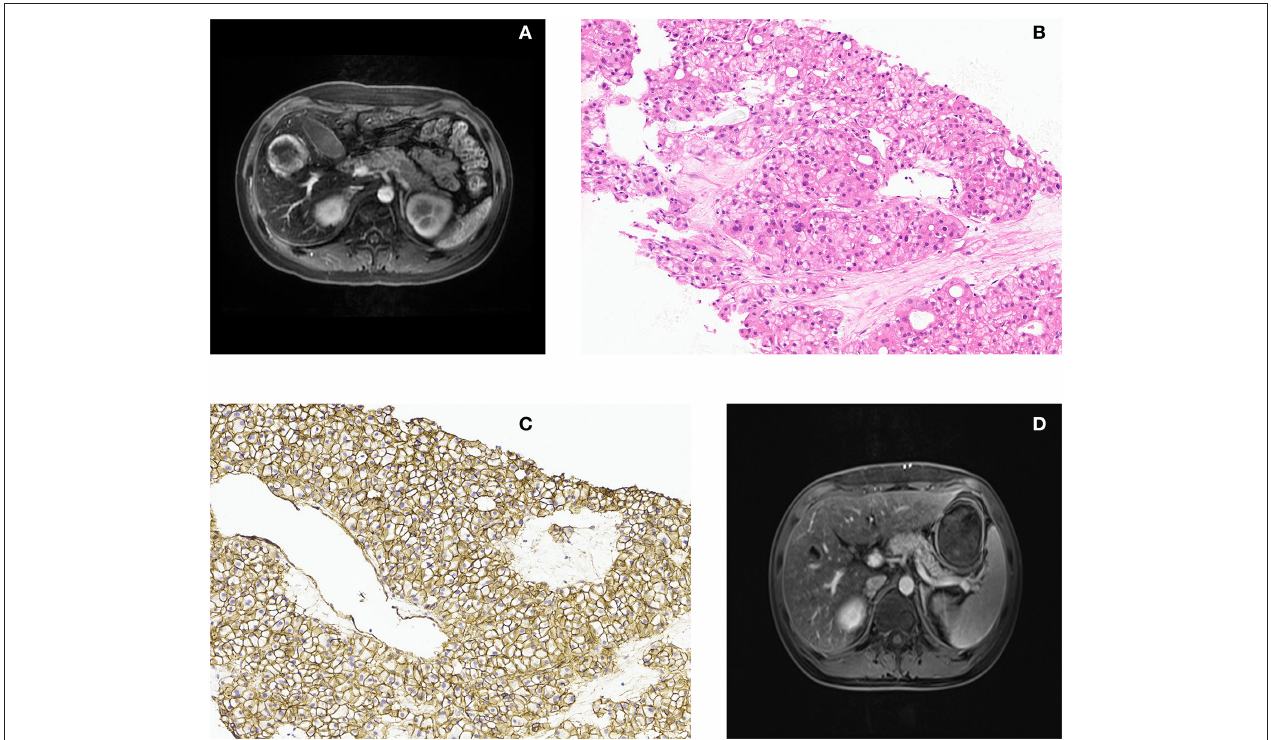
FIGURE 1 | Magnetic resonance imaging characteristics and liver biopsy histopathology. (A) Axial view from enhanced abdominal magnetic resonance imaging revealed a liver mass located in the right lobe without typical enhancement. (B) Hematein eosin stain composed of a small amount of abnormal mitotic cells, lacking the portal triads or bile ducts (original magnification × 200). (C) Immunohistochemical showed β -catenin was positive on membrane, not nuclei (original magnification × 200). (D) The radiology images showed that the mass shrank